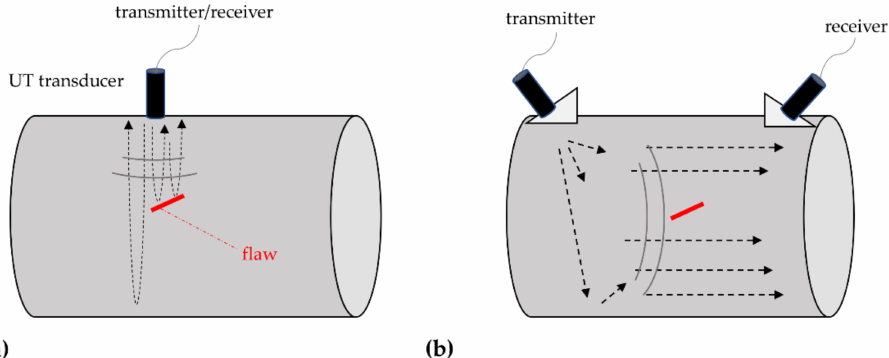
Figure 12. The basic concept of UT. ( a ) conventional, i.e., through the thickness (reflection mode), ( b ) guided waves. (through transmission